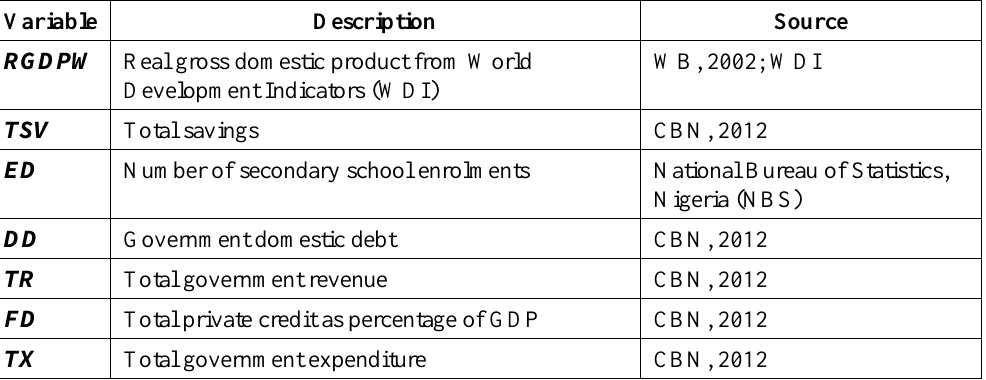
Table 1. Description of variables and data